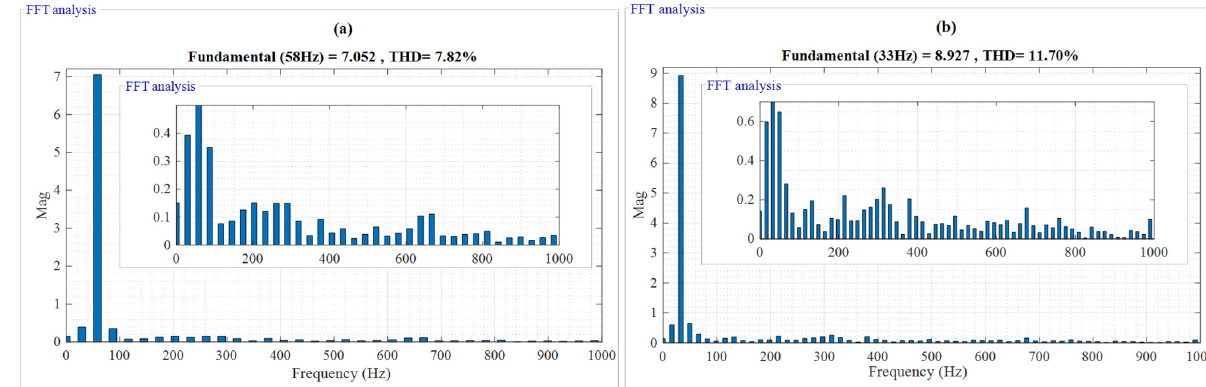
Figure 13. Stator ( a , c ) and ( b , d ) rotor currents responses of classical DTC.